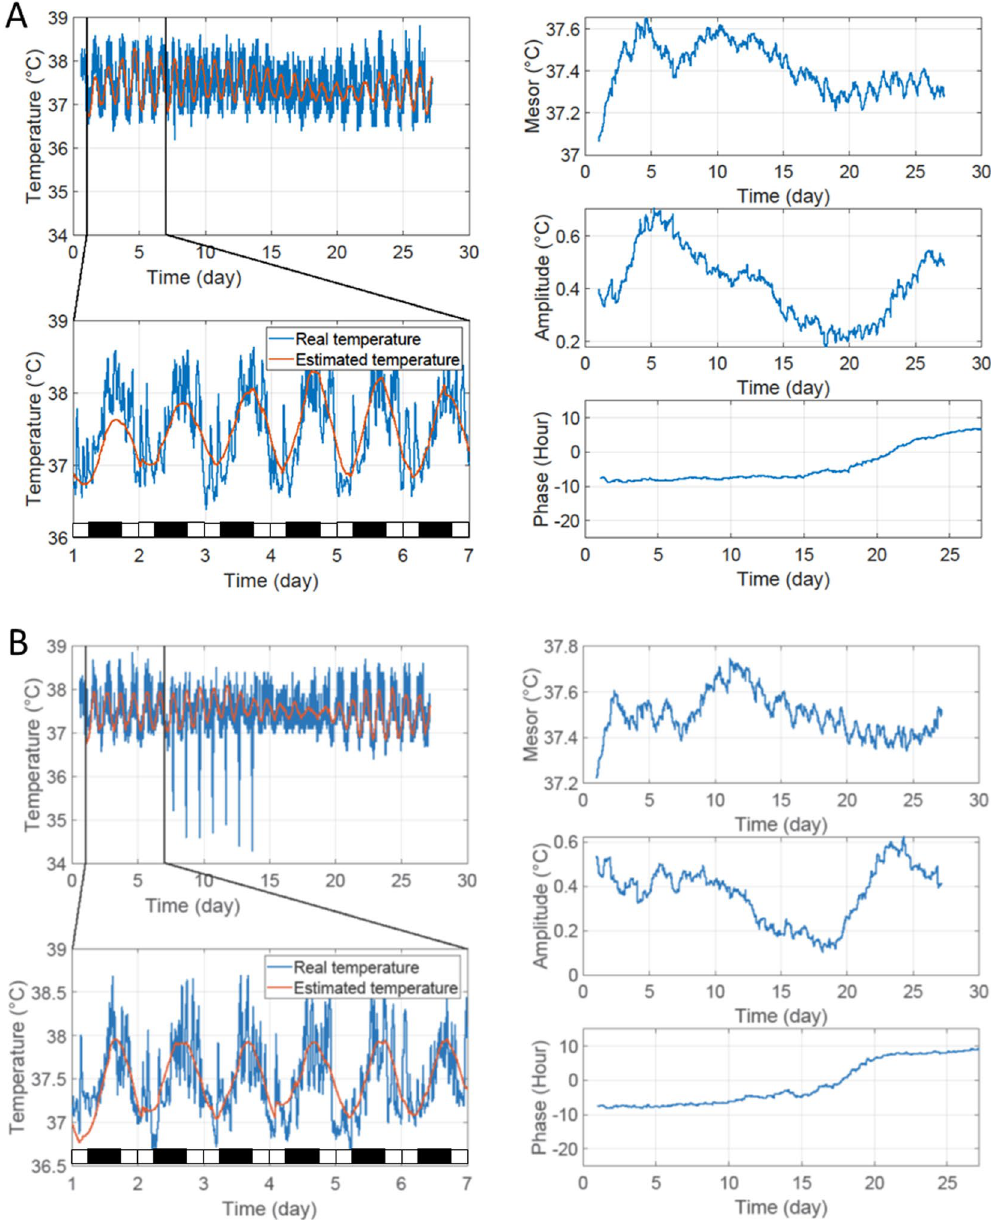
Figure 2. Resynchronization to a six-hour phase shift with 2 G stimulations (2 G/LD + 6 condition). Representative examples of a BVL ( A ) and a sham ( A ) rat in the 2 G/LD + 6 condition. The blue line represents the recorded Tc. The orange line represents the estimated Tc from the extended COSINOR analysis. The left panels represent the entire recording of temperature (left upper panel) and a zoom on the first week of recording with estimated Tc (lower panel). The black and white bars in the left lower panel symbolize dark and light periods, respectively. The right panel (from top to bottom) represents the progressive modification of mesor (°C), amplitude (°C), and phase